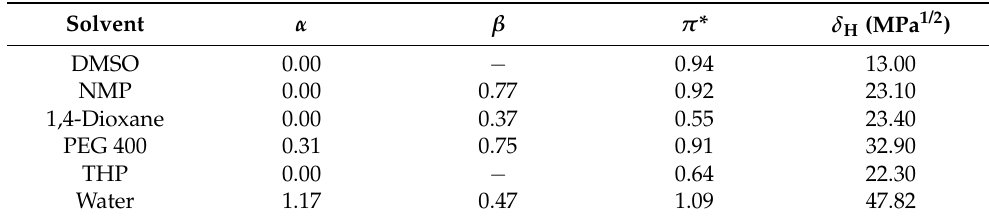
Table 3. Solvatochromic parameters ( α , β , and π *) and Hildebrand solubility parameter ( δ H ) for solvents (referred to Table 1 in Jessop et al.